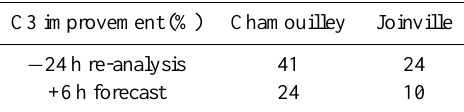
Table 3. C3 improvement between Free run and Assim run over the twenty four hours before the reference times and the six hours after the reference time. Average of four flood events in the Marne catchment, at Joinville and